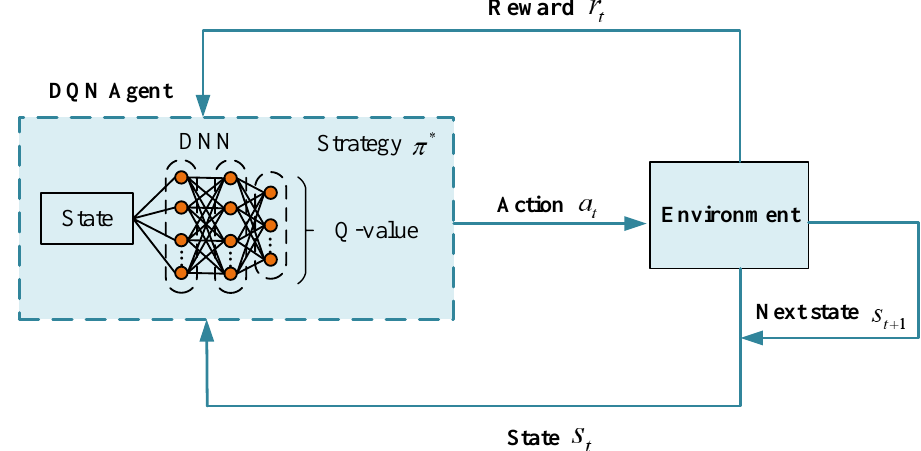
Figure 3. The framework of the DQN-based AM. State. The state space of time slot t was a combination of the ESNR values of